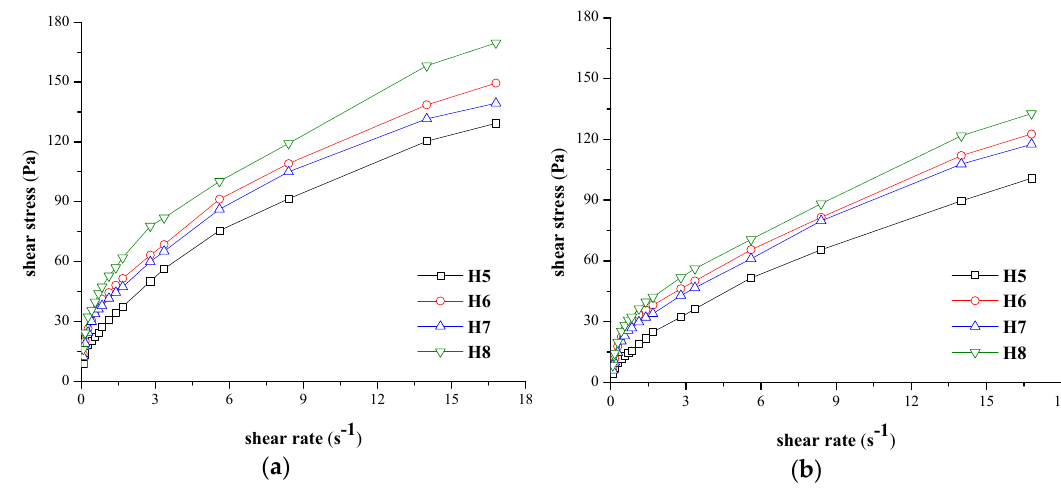
Figure 2. Cont . Figure 2. Forward rheograms for hydrogels with maximum concentration of NaCMC analyzed at: ( a ) 23 °C; ( b ) 37 °C. The determination coefficients (”R 2 ”) values (Table 1) were used as an indicator to select the hydrogel that best fitted the forward flow profiles. Table 1. Determination coefficients (”R 2 ”) values specific to different rheological models obtained in relation with forward rheograms for hydrogels tested at 23 °C and 37 °C.